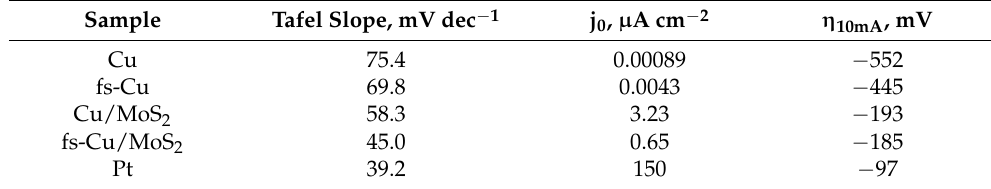
Figure 4. The Tafel slope calculations for the electrocatalytic electrodes prepared in this study. Data correspond to the LSV curves shown in Figure 3. Corrected for iR-drop. Table 2. The values of the Tafel slopes, exchange current densities, and overpotential needed to reach 10 mA cm − 2 of the HER current of the samples considered in this study.